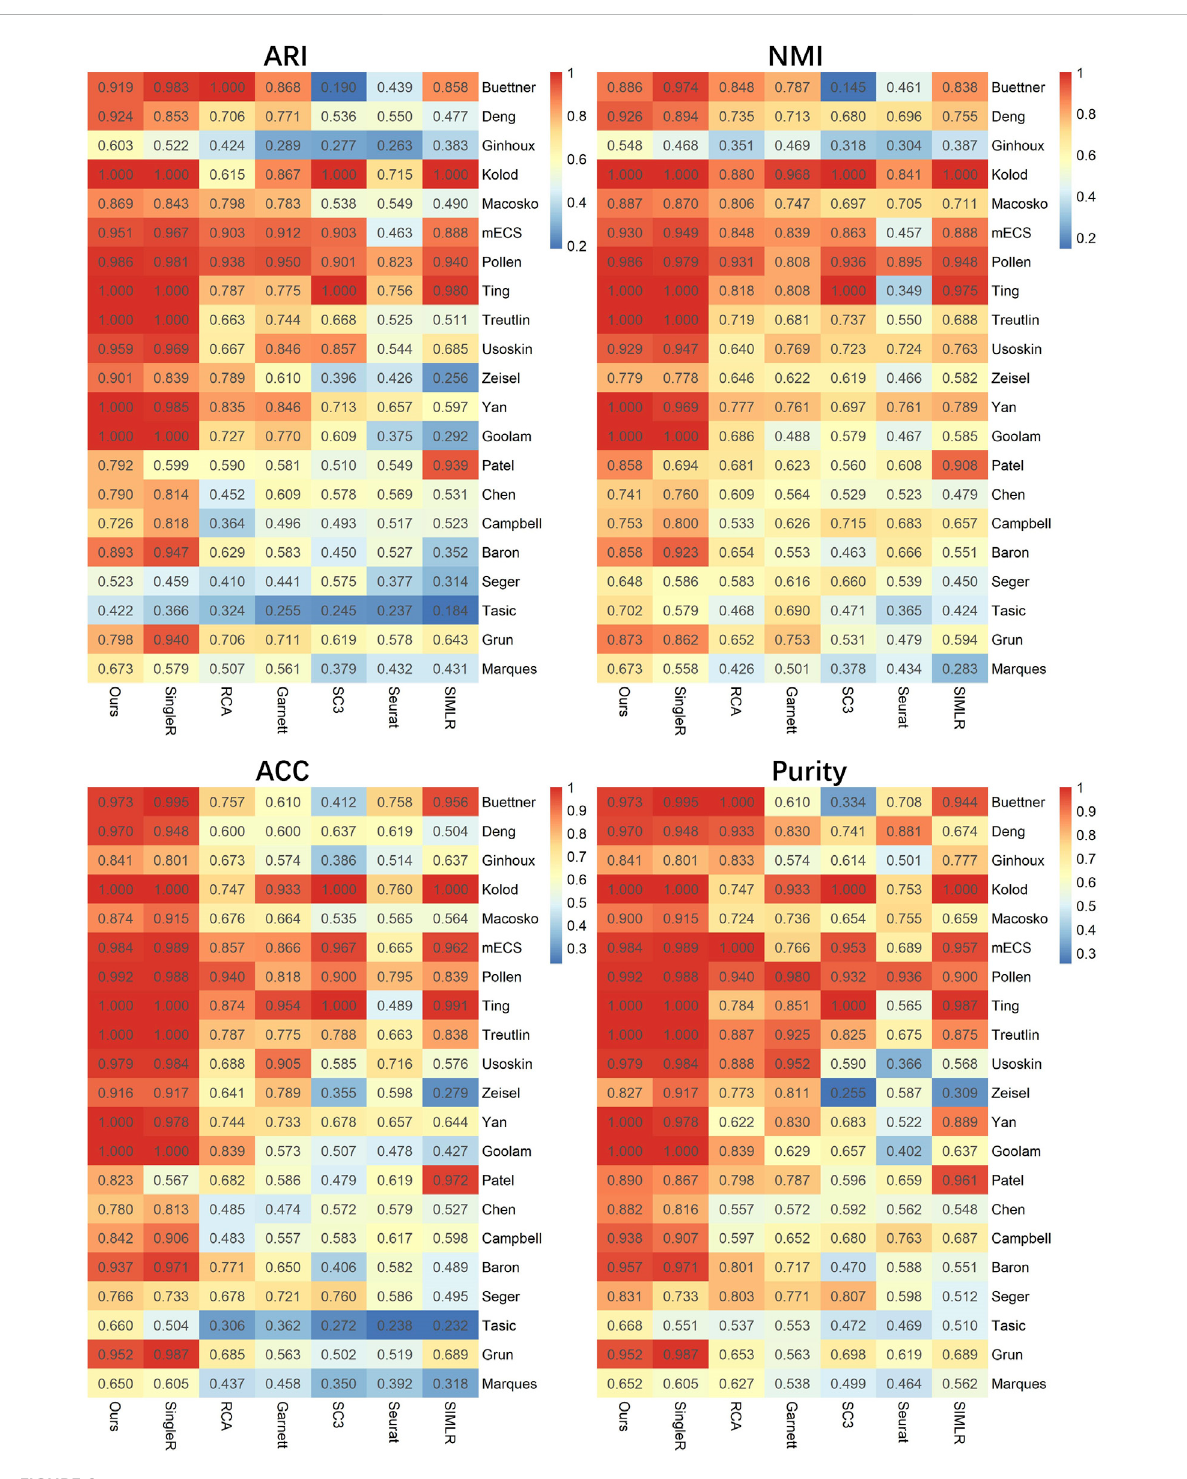
FIGURE 2 lustering evaluation (ARI, NMI, ACC, and purity) heatmap of LFSC and six baseline methods on 21 real scRNA-seq